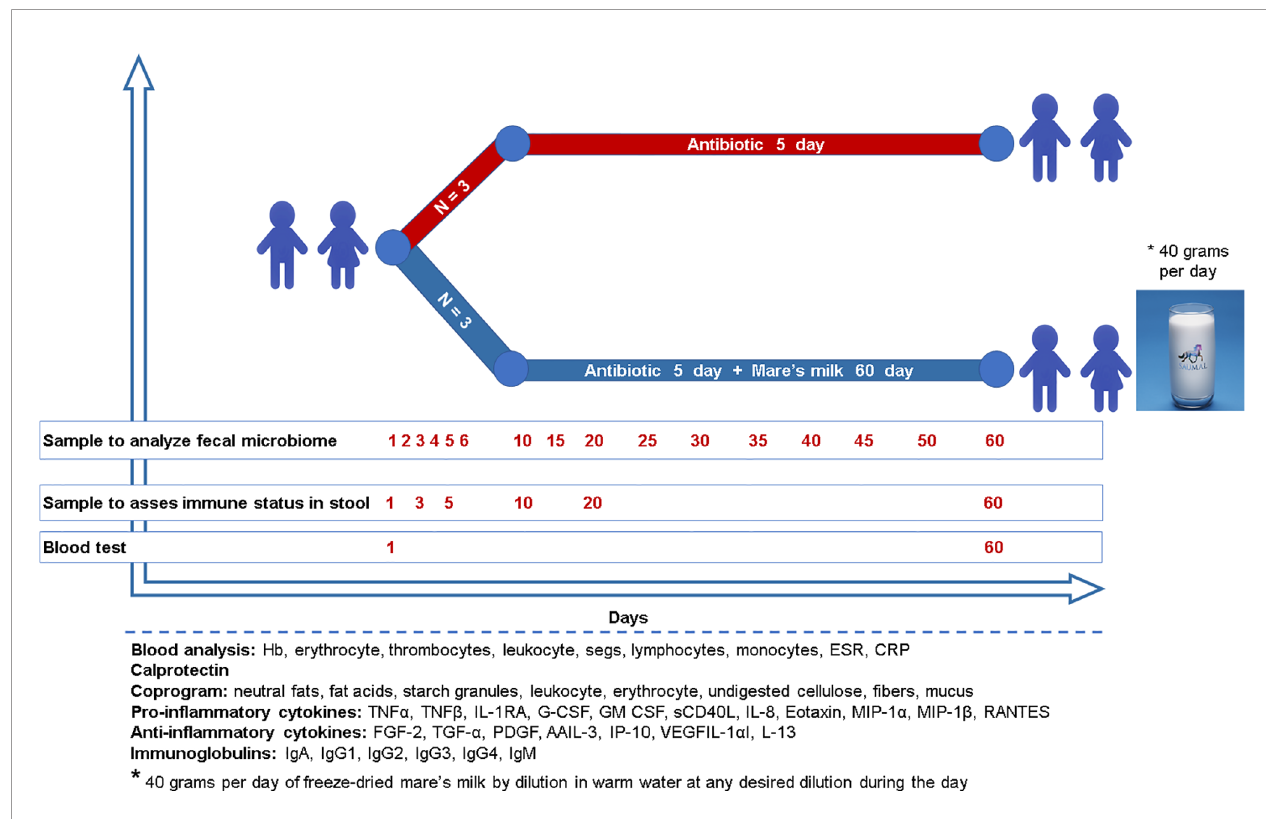
FIGURE 1 | Study design Six children (age 3.9 ± 0.7) without previous antibiotic exposure were treated with a cephalosporin because of bronchopneumonia. Three children were randomly assigned to the intervention group and administered mare ’ s milk daily for the entirety of the 5-day antibiotic intervention as well as the 55 days following. Microbiome sampling (stool or swab) and other phenotyping were performed, as shown in the diagram for both study